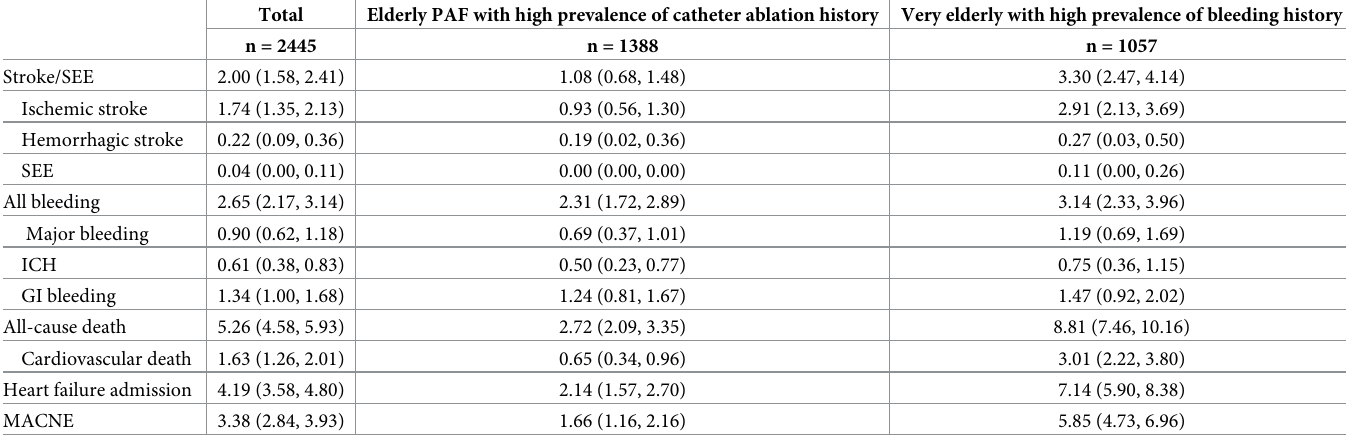
Table 2. Annualized incidence rate for clinical outcomes by